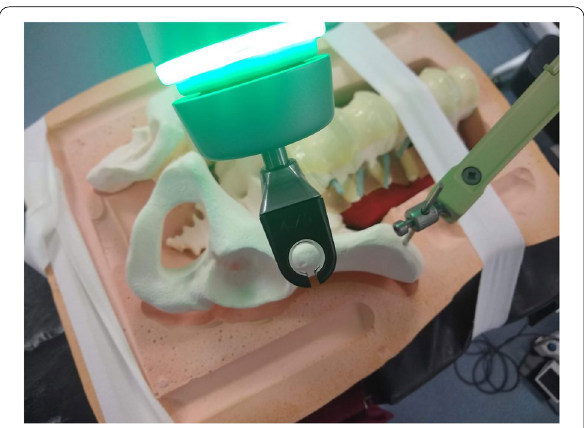
Fig. 2 View down robotic arm in preparation for LC-II screw